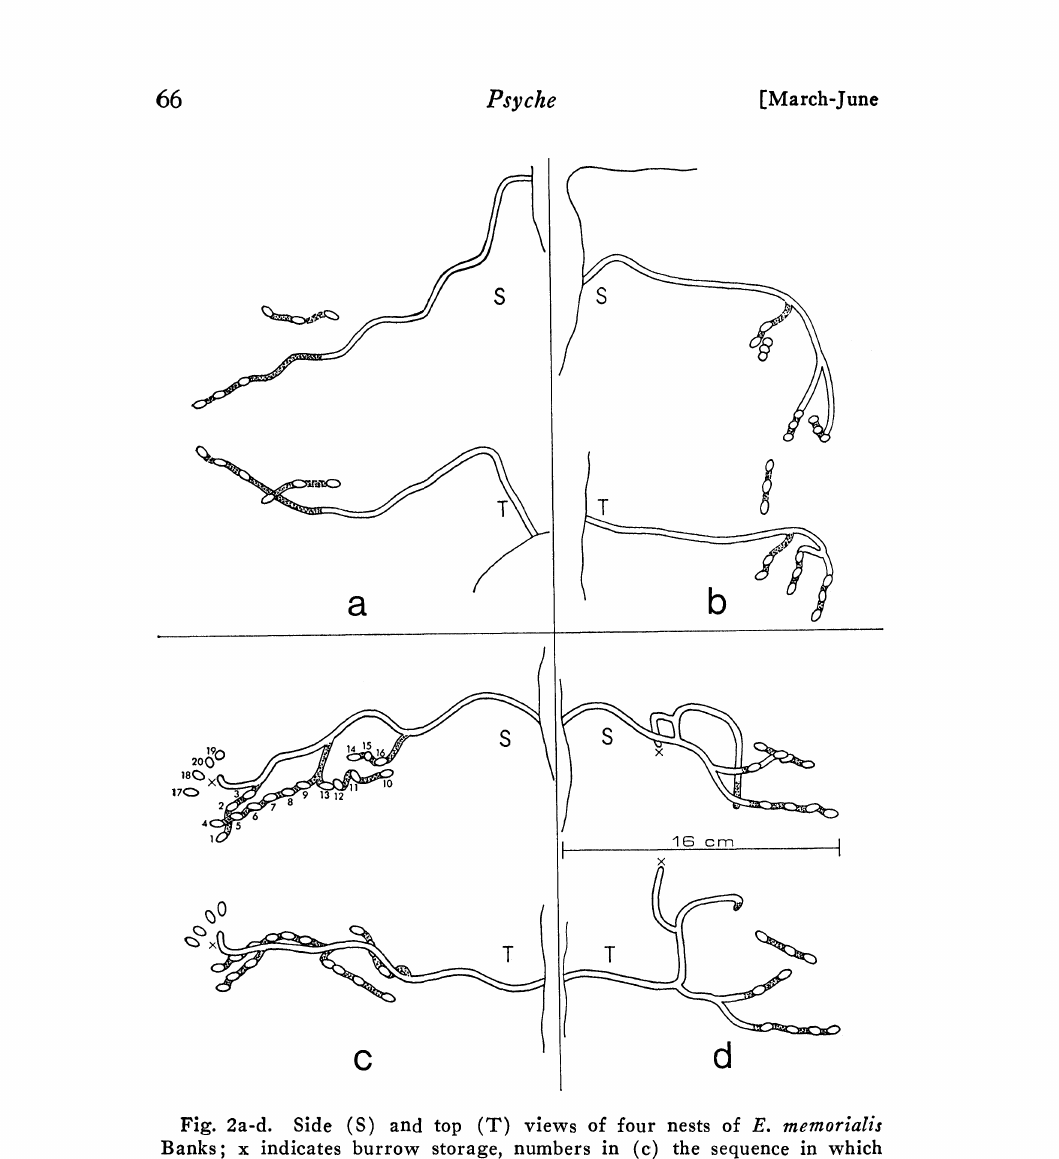
Fig. 2a-d. Side (S) and top (T) views of four nests of E. memoriaIis Banks; x indicates burrow storage, numbers in (c) the sequence in which cells were provisioned. Stippling refers to sand fill. Scale for nest (d) applies to all